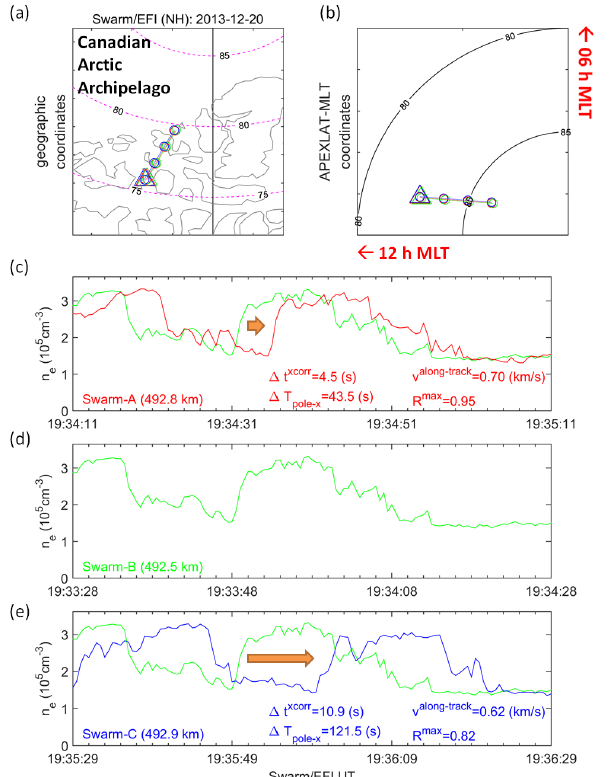
Figure 2. An example of Swarm LP data: (a) satellite track in ge- ographic coordinates, (b) satellite track in apex magnetic latitude and MLT coordinates, (c–e) electron density measured by the LP onboard Swarm-A (red), Swarm-B (green), and Swarm-C (blue). Circles in panels (a) – (b) correspond to the time stamps of panels (c) – (e) , and triangles mark the start of the time series. The green lines overplotted in panels (c) and (e) represent the density profile measured by Swarm-B but time-shifted by (cid:49)t pole − X